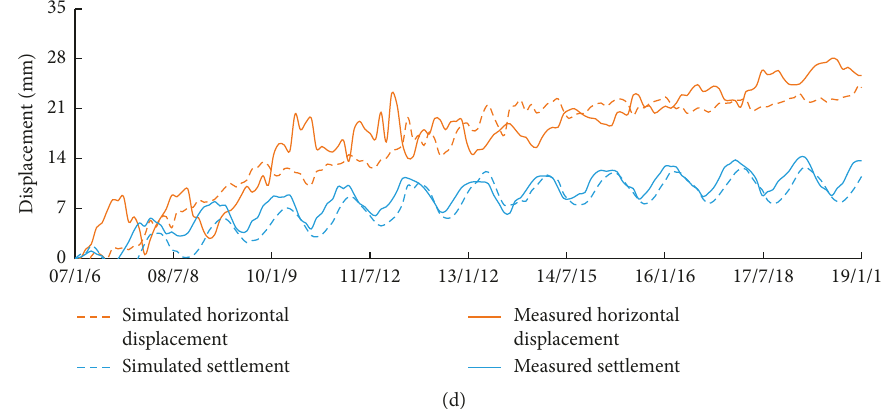
Figure 13: Processes of the simulated and measured displacements at gauging points (mm): (a) LD3-1, (b) LD4-1, (c) LD5-1, and (d)